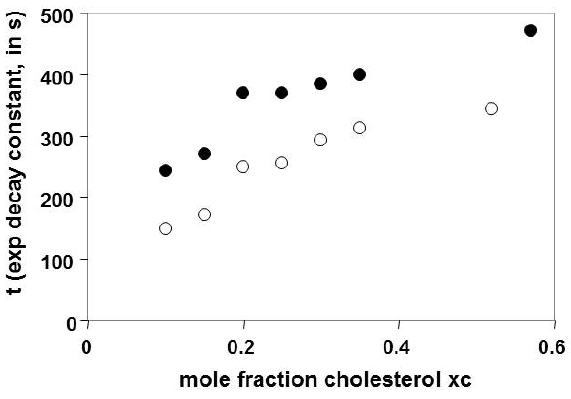
Figure 6. The exponential decay time constants for cholesterol removal from the liposomes are shown as a function of the initial cholesterol mole fraction in liposomes made from OPPC ( ● ) and POPC ( ○ ). The time constants ( t ) refer to the single exponential decay observed on addition of β CD to adsorbed liposomes; larger values for t indicate slower removal of the cholesterol. The time constants are also shown here for liposomes saturated with cholesterol using M β CD: Chl; values are for the slow pool of cholesterol, as described below. The half-life for cholesterol in the sample is given by t ln2, and therefore ranges here from 100 to 330 s.